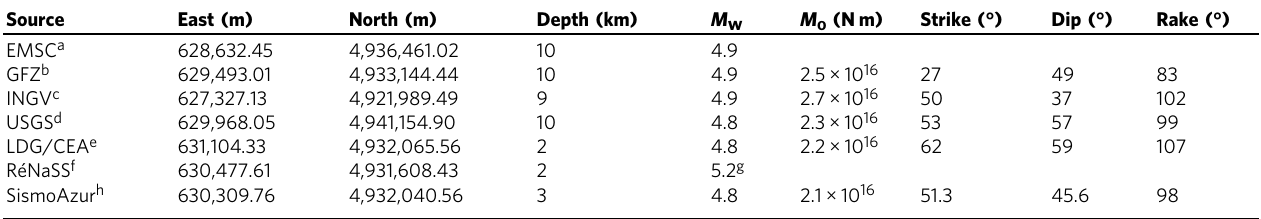
Table 1 Source parameters provided by several institutions for the November 11, 2019, Le Teil earthquake.